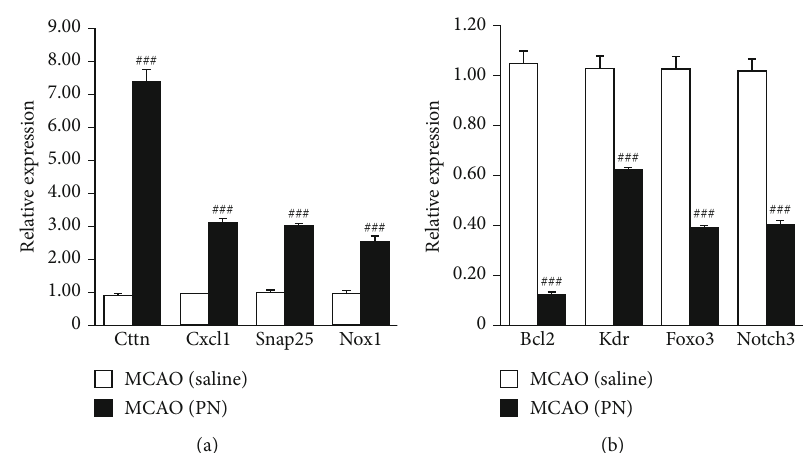
Figure 5: Veri fi cation of DEGs obtained from RNA-Seq by qPCR. Signi fi cance level according to nonparametric test (Cruskal-Wallis test, n = 6 in each group). Data shown indicated as mean ± SEM values. Similar results were obtained from at least 3 independent experiments. ∗ P < 0 : 05 ; ∗∗ P < 0 : 01 ; ∗∗∗ P < 0 : 001